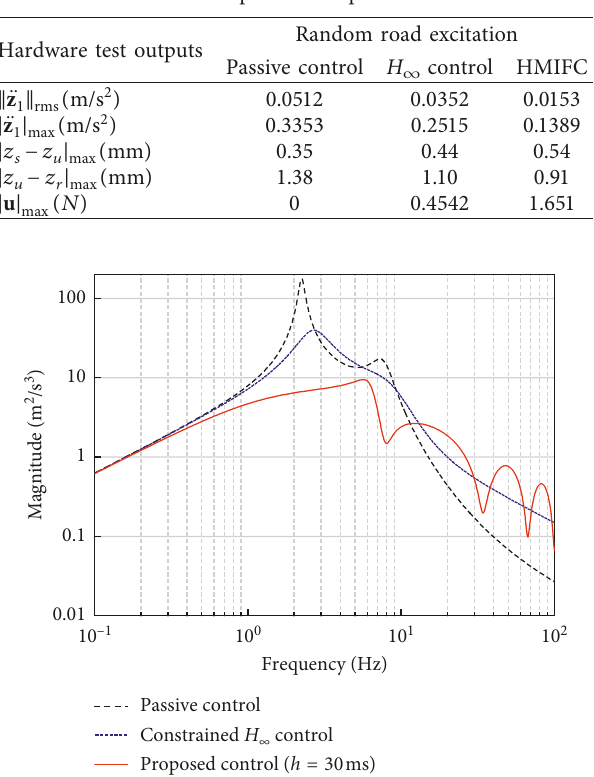
Figure 20: Frequency responses of car-body acceleration with different